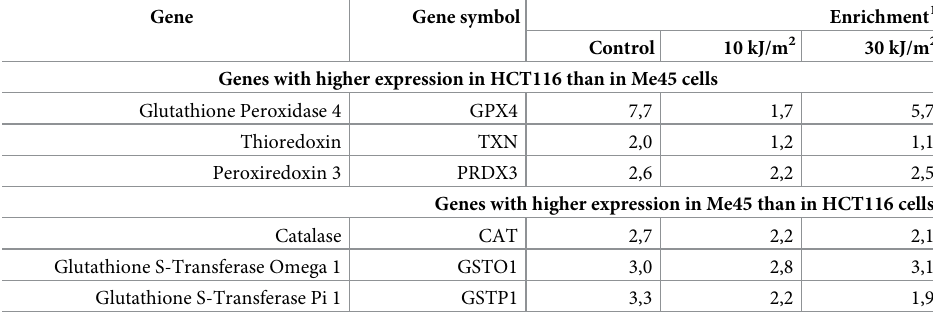
Table 4. Enrichment of selected genes expression after UVA radiation